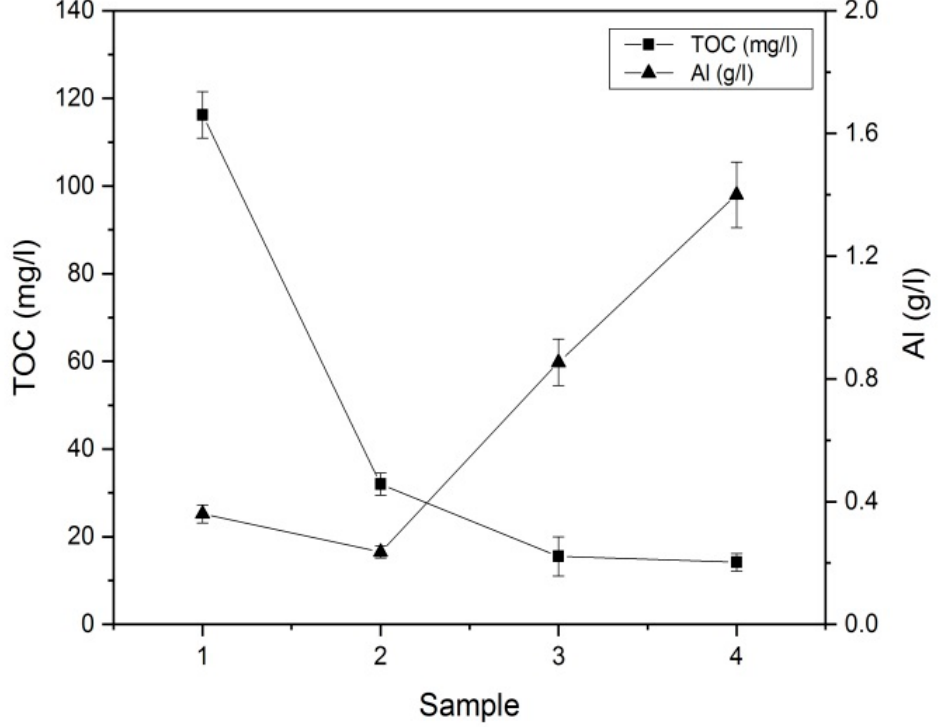
Figure 5. Change in the TOC and Al 3+ depending on sample (Sample 1: 0.1% (Al 2 (SO 4 ) 3 ) without Cu 2+ , Sample 2: 0.1% (Al 2 (SO 4 ) 3 ) with Cu 2+ , Sample 3: 0.3% (Al 2 (SO 4 ) 3 ) with Cu 2+ , Sample 4: 0.5% (Al 2 (SO 4 ) 3 ) with Cu 2+ ).